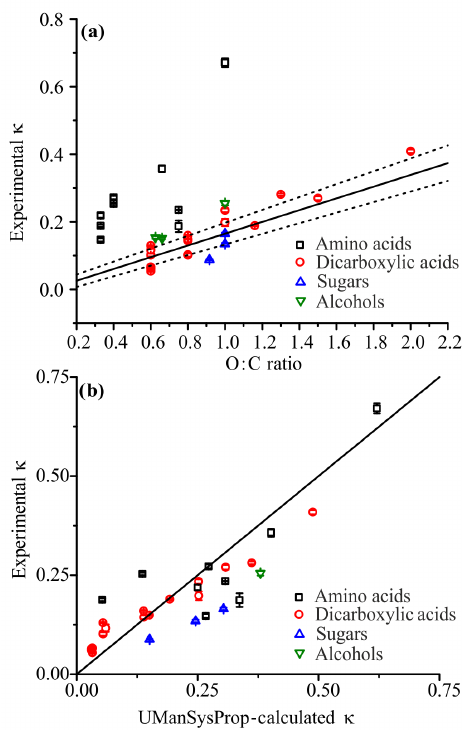
Figure 12. All values of κ for all compound classes presented as a plot of (a) κ vs. O:C ratio and (b) as a correlation plot between cal- culated κ and experimental κ . Errors are indicated but are smaller than some points. (a) The solid black line is overlaid by the form κ = (0.174 ± 0.017) × O:C − (0.009 ± 0.015), the parametrisation of Rickards et al. (2013), with the dashed black lines showing the upper and lower limits of this parametrisation. In (b) the line repre- sents y = x